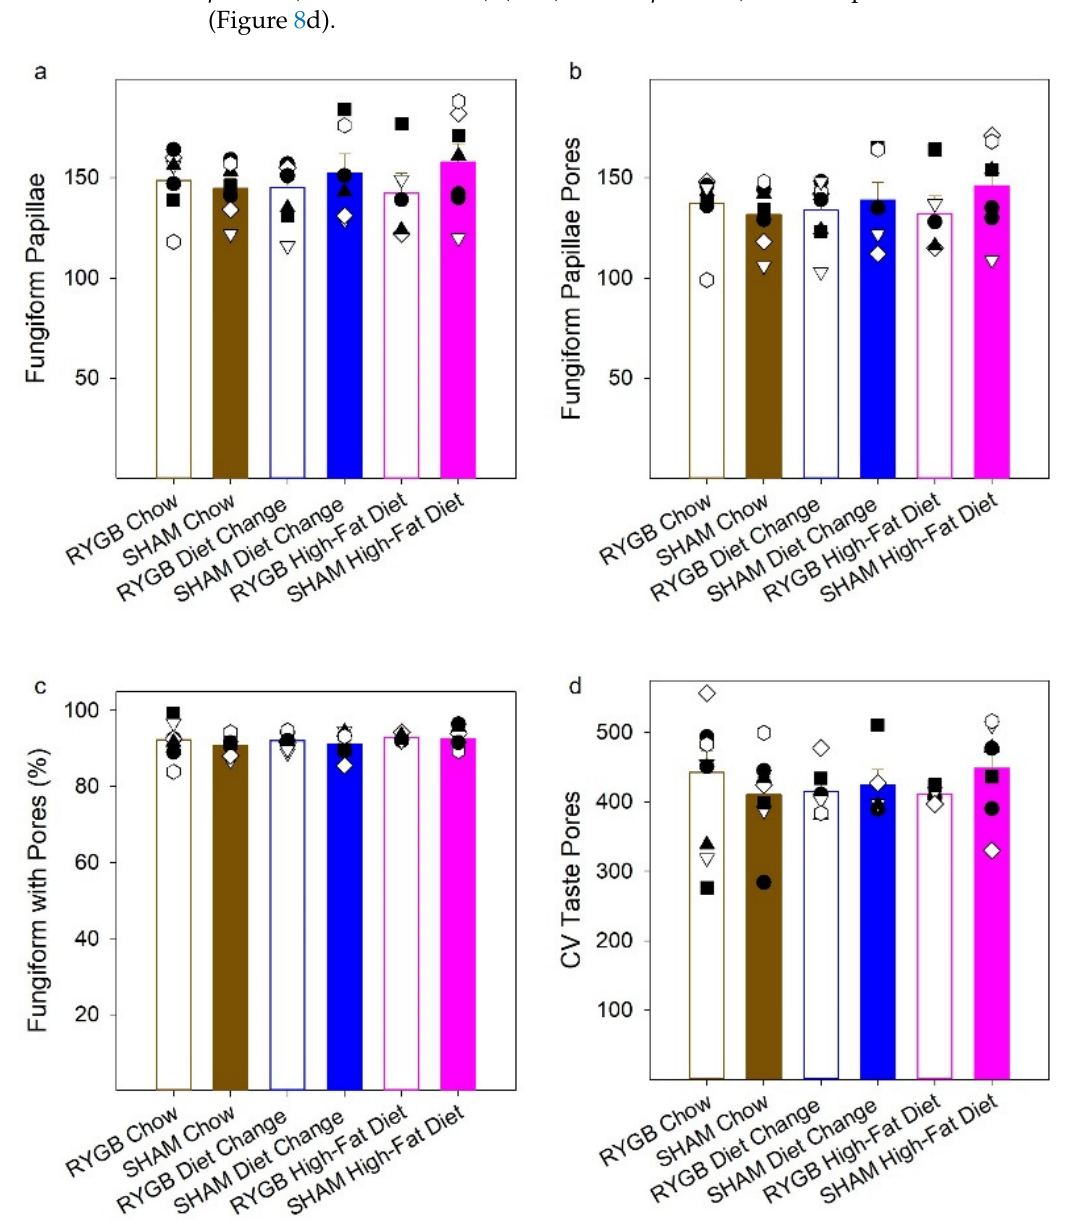
Figure 8. Histological analyses. Mean ( ± SE) and individual number of fungiform papillae ( a ), number of taste pores in the anterior tongue ( b ), percent of fungiform papillae that had a taste pore ( c ), and number of taste pores in the circumvallate papillae ( d ). RYGB groups are in open bars, SHAMs, in filled. Diet groups are represented as brown for the Chow group; blue, the diet change; pink, the high-fat diet.